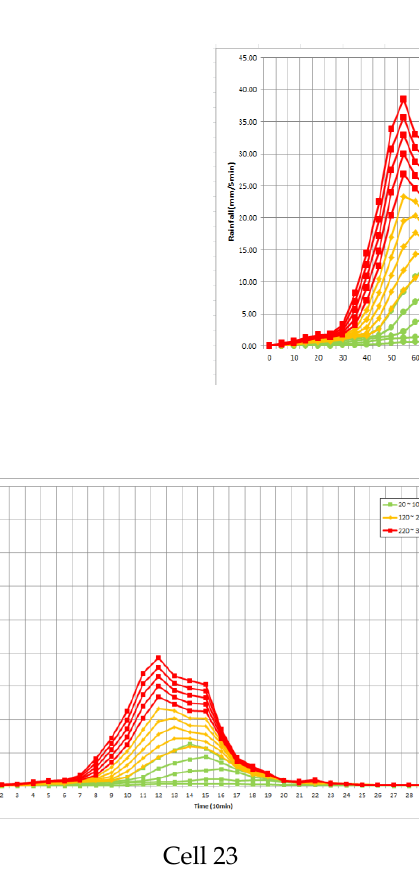
Figure 14. Result of runoff in the study area.